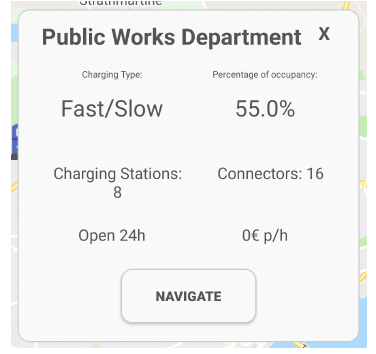
Figure 4. Pop-up information board on a